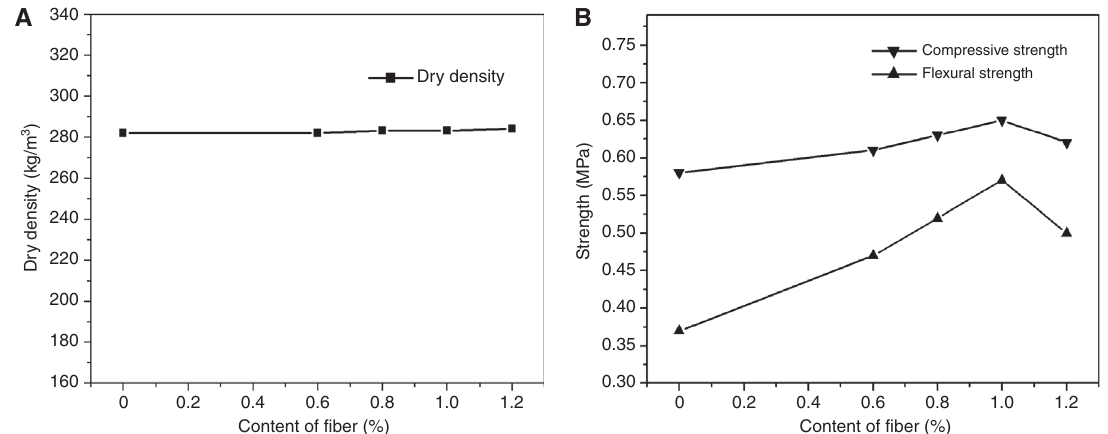
Figure 5 Effect of different contents of treated glass fiber on the density and strength of the samples. (A) Effect on dry density of samples. (B) Effect on strength of samples.